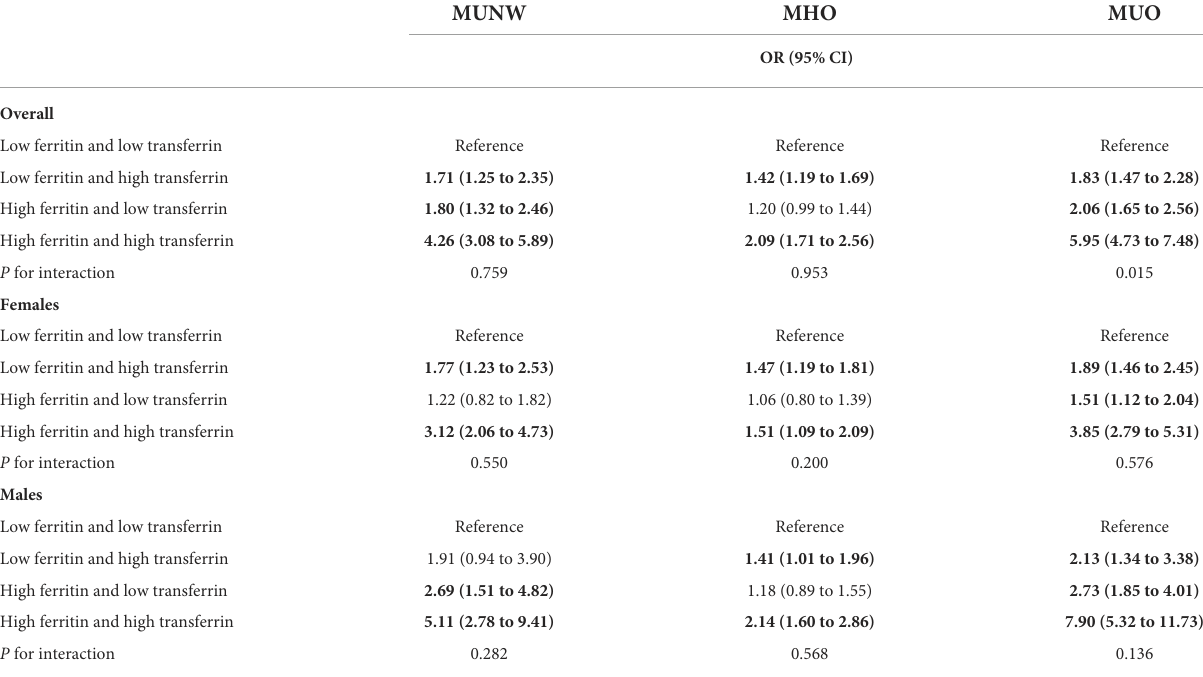
TABLE 4 Odds ratios and 95% CIs of different metabolic obesity phenotypes by four iron groups in CHNS